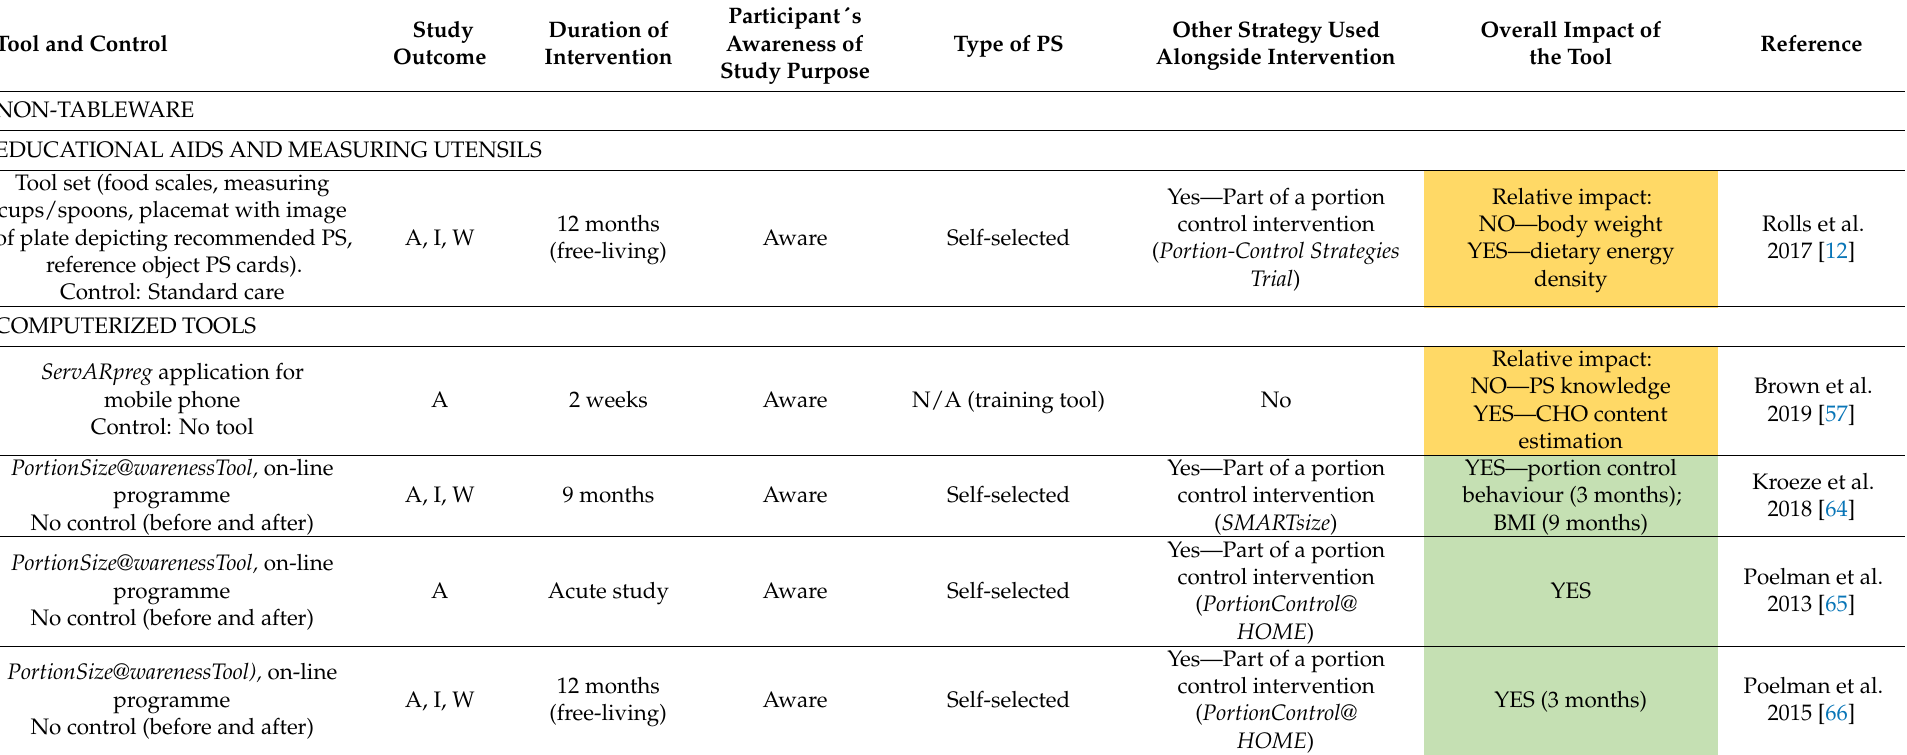
Table 2. Overview of the 40 studies included in the review (36 publications) with data on potential covariates (participant awareness of study purpose, type of portion size offered (self-selected vs. fixed) and presence of other strategies used alongside portion size modification). All studies were carried out in adults except when otherwise indicated under “Tool and control”. The term calibrated is used to describe a portion control utensil with either printed indicators or indented segments (3D). Overall impact of tool is coded as follows: Green—beneficial impact of the small or intervention tool; Orange—relative impact; No color—insufficient evidence or no impact shown. Abbreviations: CHO, carbohydrate; FV, fruit and vegetables; PRO, protein; PS, portion size. Study outcome A, Portion size awareness; C, Portion size choice; I, Portion size intake; W, Weight status. Participant ´ s Duration of Other Strategy Used Overall Impact of Awareness of Type of PS Outcome Intervention Alongside Intervention the Tool Study Purpose